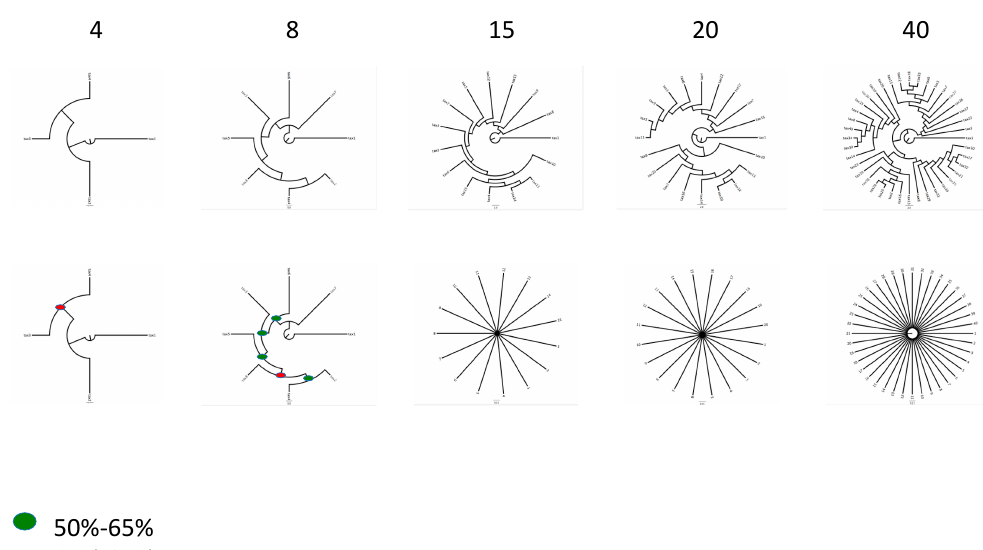
Figure 1. Results of the Ithink experiment. The number of taxa for each part of the experiment is given above the trees. The top row shows the most parsimonious tree obtained for each matrix and the bottom row shows the bootstrap trees for each of the five experiments (NTAX = 4, 8, 15, 20 and 40). Red dots indicate nodes with BP between 66% and 85%. The green dots indicate nodes with BP between 50% and 65%. Construction of the Ithink matrices is described here. We first extracted the text from Darwin’s On the Origin of Species . The first 100 letters of the text were turned into a line corresponding to taxon 1, the next 100 letters are turned into a line corresponding to taxon 2, the next 100 letters are turned into a line corresponding to taxon 3 and the next 100 letters are turned into a line corresponding to taxon 4. The process starts over again for the four taxa with the next 100 letters and so on for 100 partitions. The next step is to remove spaces and any letters in the alphabet that do not correspond to an amino acid. These are replaced with ambiguous X’s. Next the individual lines for each partition are transformed into FASTA files and aligned using MAFFT [67] with default settings. Finally, the matrices are formatted for phylogenetic analysis and analyzed using PAUP [68]. We used parsimony as an optimality criterion and weighted all characters equally. The searches were accomplished using 200 rounds of random taxon addition with tree bissection reconnection (TBR) branch swapping. We focused the analyses to be very simple and point out that results using parsimony here will indeed be di ff erent from those using likelihood or Bayesian approaches. We obtained bootstrap proportions for the trees shown here using the “boot” option in PAUP with 100 replicates. The “ithink” matrix is available from the authors upon